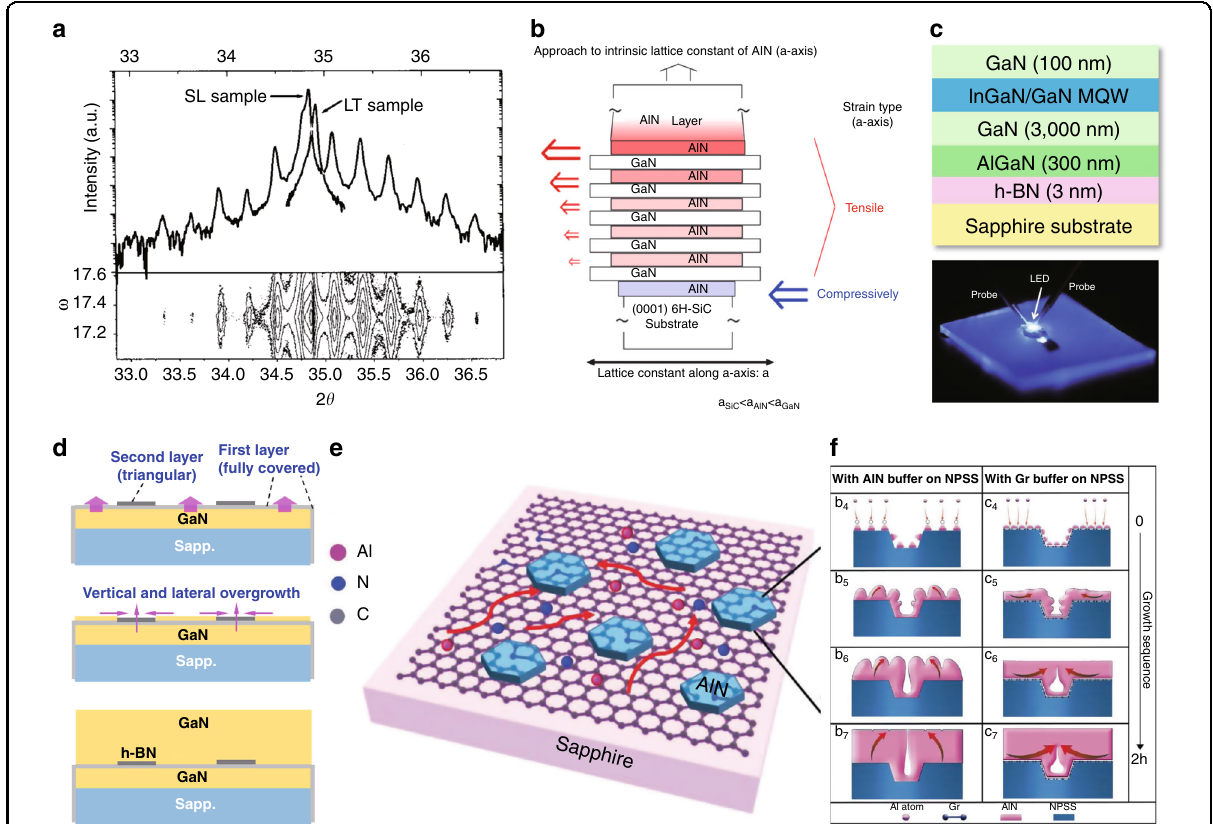
Fig. 6 Van der Waals epitaxy for mis fi t strain release. a XRD scans of the 3.0mm SL and low-temperature buffer AlN samples (upper) and (0002) mapping of the SL sample. b Model of strain control of the AlN template by the introduction of the (AlN/GaN) multi-buffer layer. c (Upper) Single-crystal h- BN release layer growth on sapphire for AlGaN MQWs and (lower) optical image of the blue light EL from the transferred vertical-type LED. d Schematic diagram illustrating the overgrowth process of GaN thick epilayer on the h-BN buffered GaN/sapphire template. e Schematic diagram of the nucleation and fi lm growth of AlN on N fi lms grown with low- 2 -plasma-treated graphene/sapphire substrate. f Schematic illustration of morphology evolution for AlN temperature AlN buffer and graphene buffer, respectively. Figures reproduced from a ref. 87 , © 2002 AIP Publishing; b ref. 88 , © 2007 Elsevier; c ref. 92 , © 2012 Springer Nature; d ref. 93 , © 2016 Springer Nature; e ref. 94 , © 2014, American Chemical Society; f ref. 96 , © 2020, John Wiley and